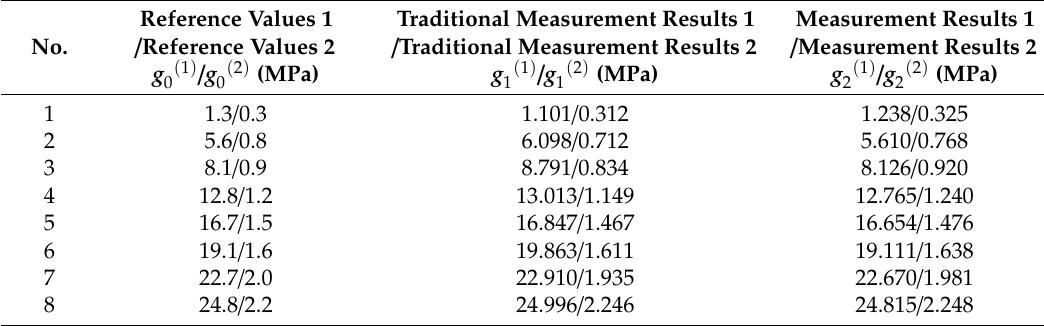
Table 8. Measurement readings of two pointer meters by two methods.